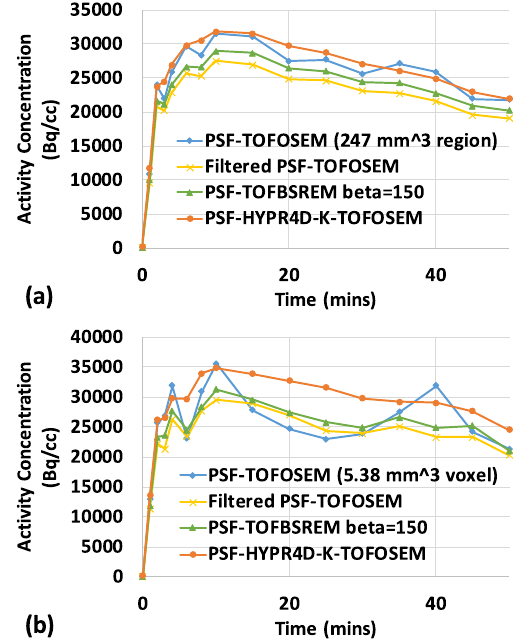
Fig. 3 a Regional‑level TAC and b voxel‑level TAC comparisons in the caudate of the human [ 11 C]RAC scan reconstructed using various